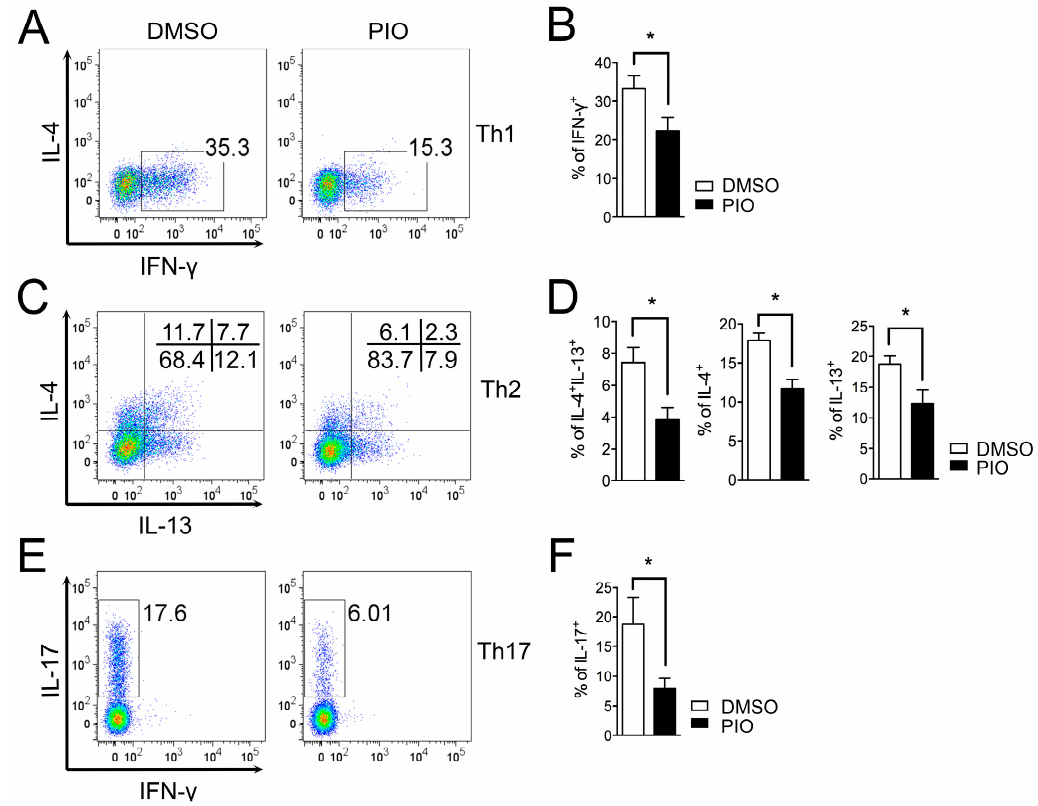
Figure 1. PPAR γ activation by pioglitazone treatment inhibits Th1, Th2, and Th17 differentiation in female mouse T cells. MACS-purified CD62L high CD44 low naïve T cells from the spleens of six- to eight-week-old female C57BL/6 mice were differentiated into Th1 and Th17 cells for three days and Th2 cells for five days in specific cytokine media for T cell–skewing conditions in the presence of DMSO or pioglitazone (20 µ M). The proportions of IFN- γ –positive cells in Th1 differentiation ( A , B ); IL-4– and IL-13–producing cells in Th2 differentiation ( C , D ); and IL-17A–expressing cells in Th17 differentiation ( E , F ) were determined by flow cytometry and demonstrated as the dot plots. Values represent mean ± SEM ( n = 5~6). * p < 0.05.